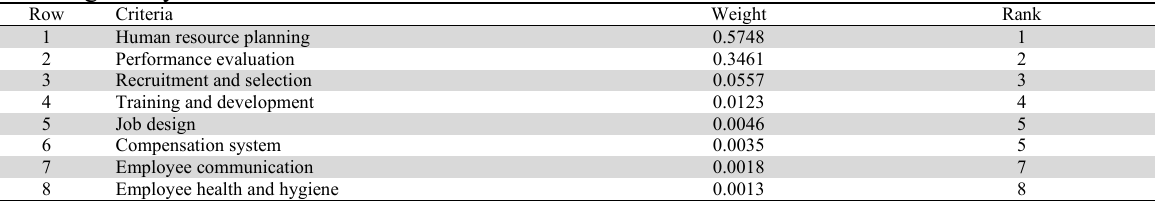
Ranking of key HRM